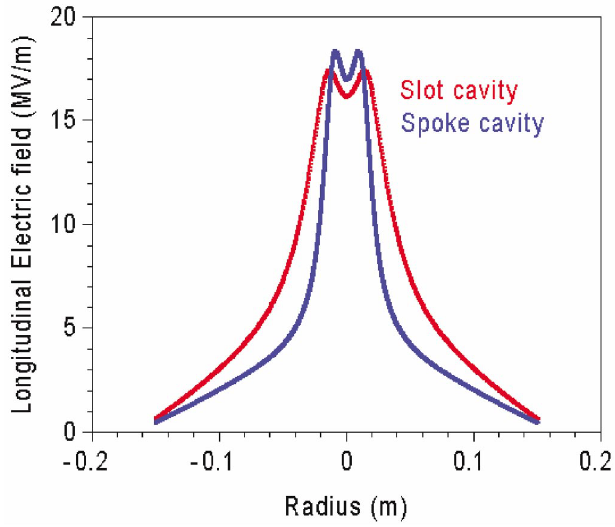
FIG. 7. (Color) The longitudinal component of the electric field in the center of the accelerating gap in the slot and spoke (cid:4) 40 MV = m . resonators at E peak